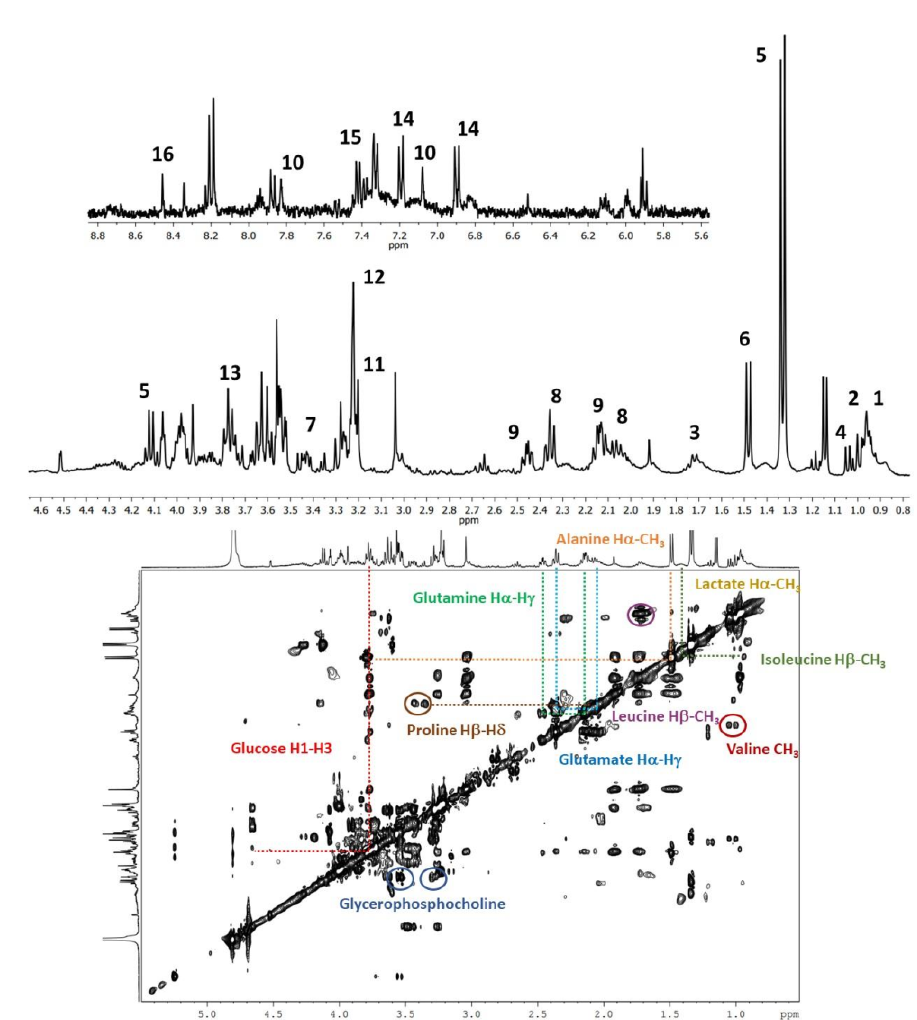
Figure 1. 1 H-NMR HR-MAS spectrum of WT tissue sample acquired using a CPMG ( cpmgpr1d ) pulse sequence; two regions are presented in the lower panel at 0.50 and 4.70 ppm, and, in the upper panel, the region between 5.0 and 9.00 ppm is amplified 20 times. Sixteen metabolites were identified: fatty acids (CH 3 -) (1), isoleucine (2), leucine (3), valine (4), lactate (5), alanine (6), proline (7), glutamate (8), glutamine (9), histidine (10), choline (11), glycerophosphocholine (12), glucose (13), tyrosine (14), phenylalanine (15), and formate (16). At the bottom the 1 H- 1 H TOCSY spectrum is shown (aliphatic region, 0.00–5.50 ppm) with marked